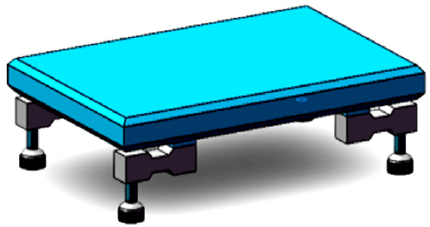
Figure 5. Test hardware structure.